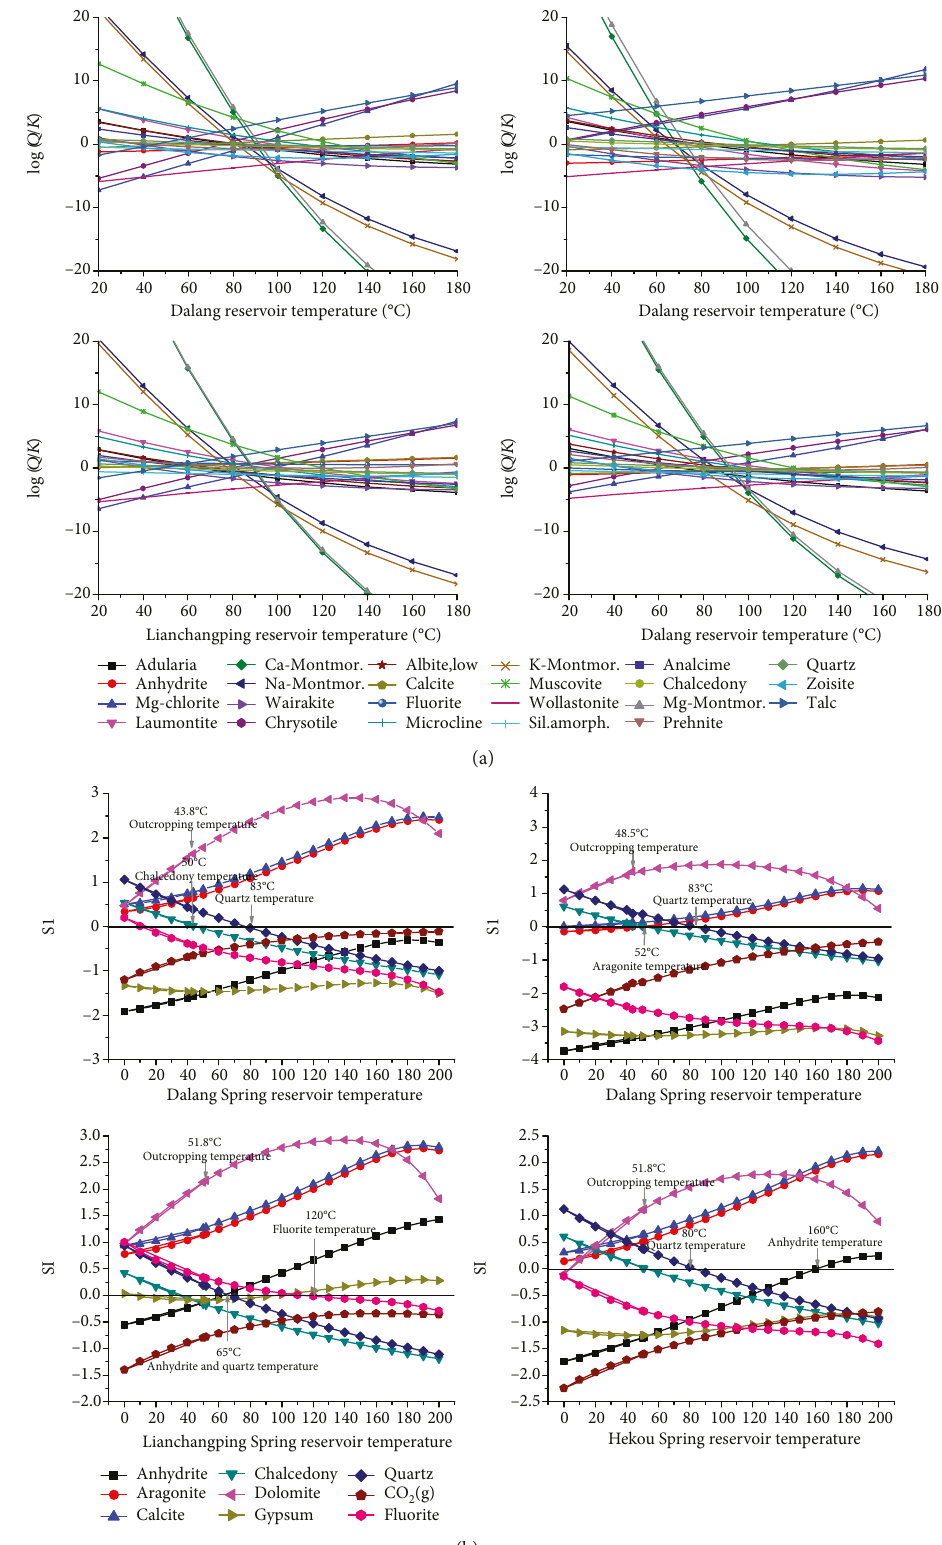
Figure 3: Log( Q / K ) versus T (multicomponent geotemperature) plot for the four thermal springs calculated by the PHREEQC program (a) and WATCH program (b). The measured outcropping temperature is shown in Table